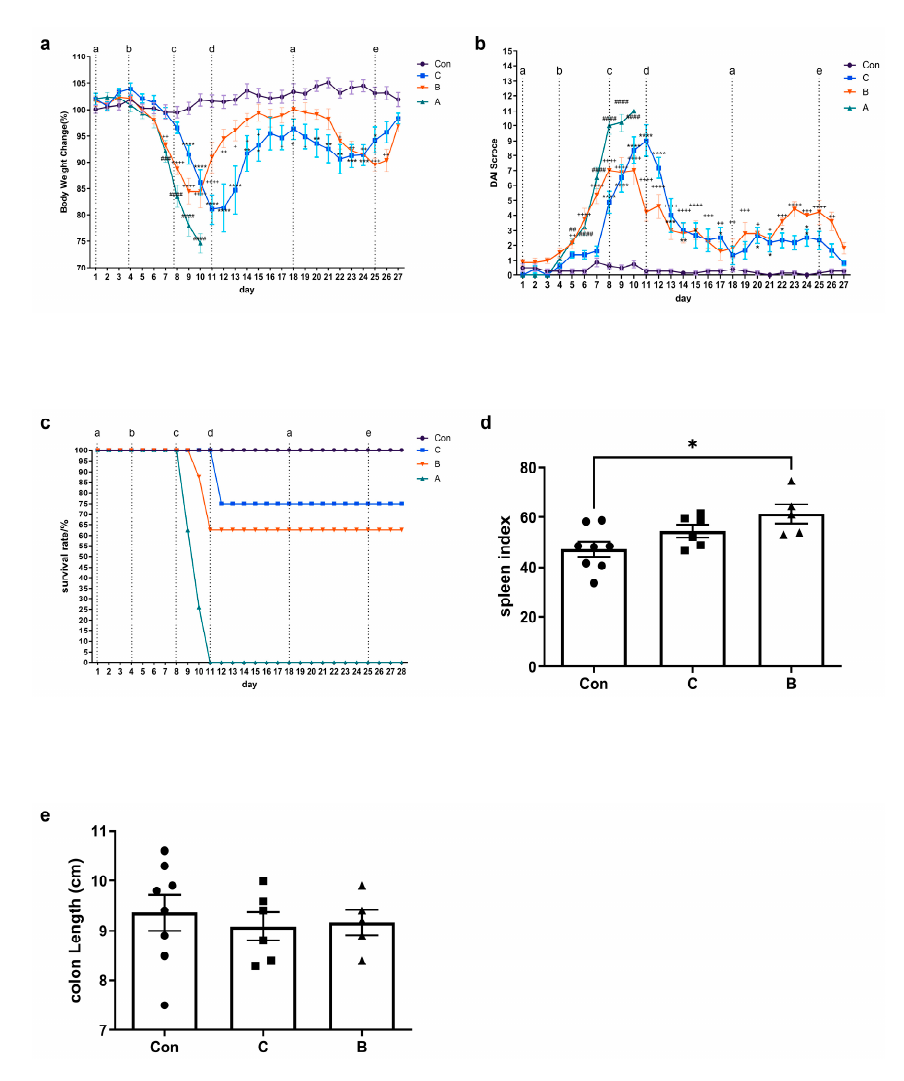
Figure 2. Long-term administration of DSS is more suitable. ( a ) survival rate, ( b ) body weight change, ( c ) DAI score of mice, ( d ) spleen index, and ( e ) colon length of mice. The percentage of body weight change was calculated relative to the body weight at day 0. The value was evaluated daily and is shown as the mean ± SEM for 5–8 animals per group. The survival rate was defined as the absence of mouse mortality or the loss of mice to 20% of their pre-experimental body weight during the experiment. The spleen index was calculated according to the following formula: spleen weight (mg) × 10/body weight (g). For ( a – c ): group C vs. the control group, * p < 0.05, ** p < 0.01, *** p < 0.001, **** p < 0.0001; group B vs. the control group, + p < 0.05, ++ p < 0.01; +++ p < 0.001; ++++ p < 0.0001; group A vs. the control group, # p < 0.05, ## p < 0.01, ### p < 0.001, #### p < 0.0001. a: group C started to drink autoclaved water with 2% DSS; b: group B/A initiated drinking autoclaved water at 3% DSS or 4% DSS; c: group C commenced drinking autoclaved water with 4% DSS; d: returned to drinking autoclaved water; e: group C began drinking autoclaved water. For ( d , e ): ● represents the individual in group con, ■ represents the individual in group C, ▲ represents the individual in group B, * p < 0.05.